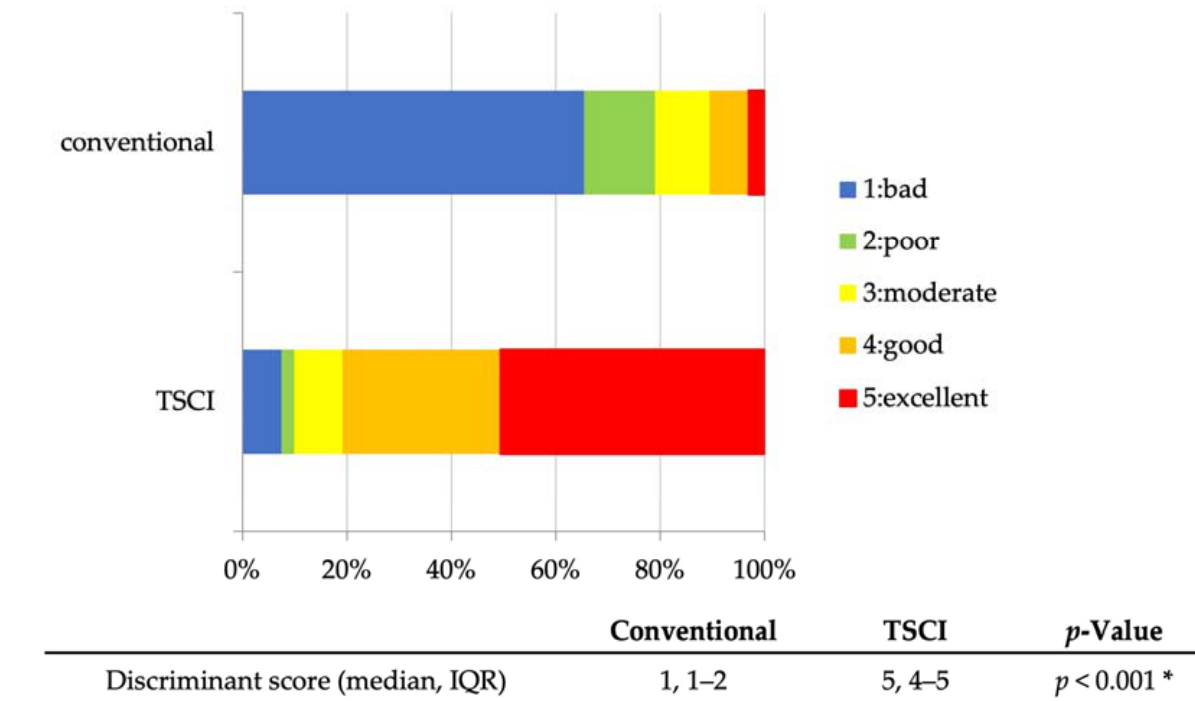
Figure 3. Discriminant scores for EUS ‐ FNA sample (conventional vs. TSCI). Discriminant scores for EUS ‐ FNA samples by the six raters. The TSCI observations had significantly higher discriminant scores than the conventional method. Abbreviations: EUS ‐ FNA, endoscopic ultrasound ‐ guided fine ‐ needle aspiration; TSCI, target sample check illuminator; and IQR, interquartile range.